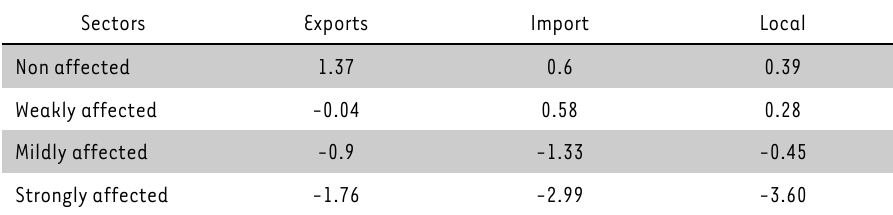
TABLE 2: Impact on exports, imports and local sales (in %) Sectors